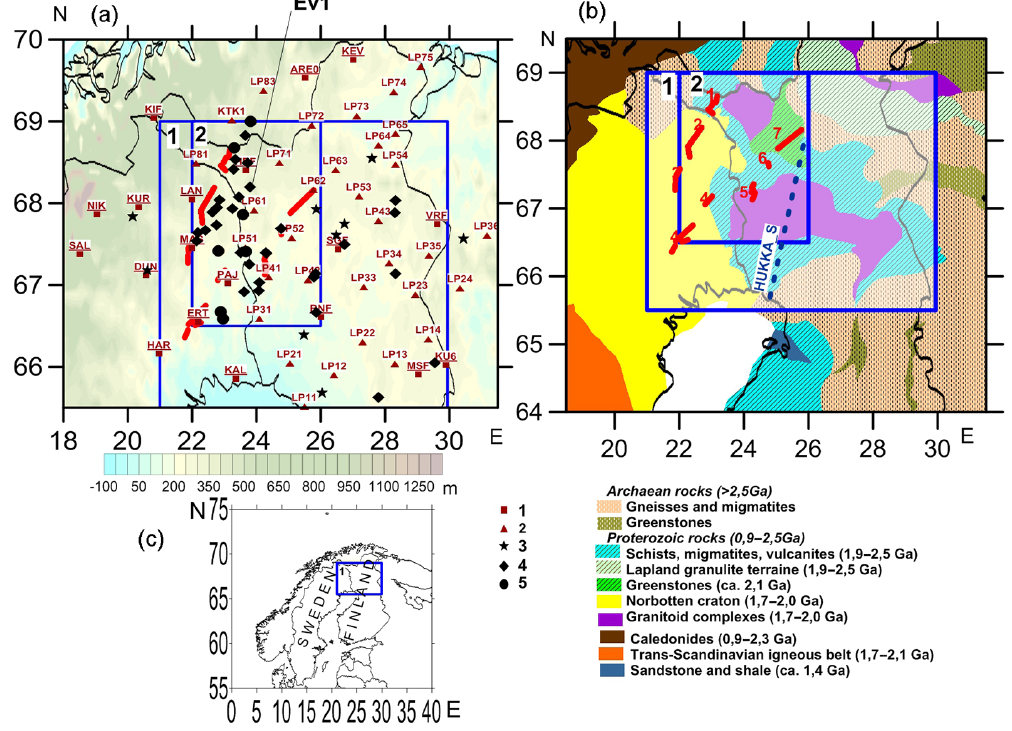
Figure 1. (a) Location of the POLENET/LAPNET stations (1 – permanent, 2 – temporary) and local events (3 – explosions, 4 – shallow earthquakes with depths less 20km, 5 – deep earthquakes), imposed on topographic map ETOPO1 (Amante and Eakins, 2009, http://maps. ngdc.noaa.gov/viewers/wcs-client/); (b) the geological map, based on a 1 : 2000000 geological map of Fennoscandia (Koistinen et al., 2001); (c) large-scale map for demonstrating where the study area is located in Fennoscandia. Red lines in (b) (with red numerals) are denoted postglacial faults (Sutinen et al., 2014; Mikko et al., 2015): 1 – Palojärvi, Paatsikkajoki and Kultima, 2 – Lainio-Suijavaara, 3 – Merasjärvi, 4 – Lansjärv, 5 – Venejärvi, Ruostejärvi and Pasmajärvi, 6 – Isovaara, 7 – Suasselkä. Blue boxes show investigation of Regions 1 and 2. Region 1 is the region for tomographic research and Region 2 is the region for reliable location. Blue dotted line denotes position of the HUKKA S profile. Epicentres are given according to the FENCAT. Ev1 denotes event from Table 4 with determined focal mechanism (the seismic catalogue from all the Nordic countries, www.seismo.helsinki.fi).